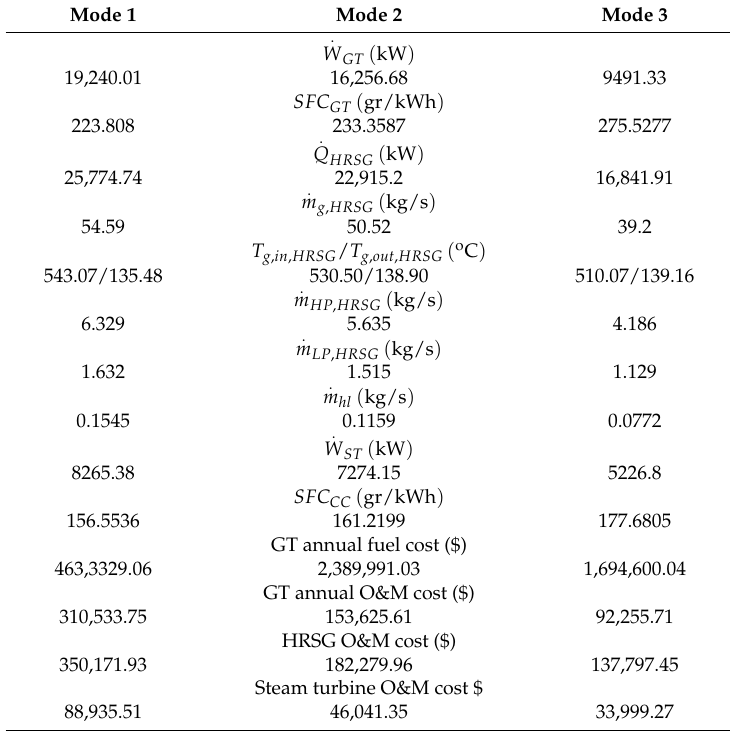
Table 7. Operational technical and economic characteristics for the system with gas turbine type (a) and fuel MDO.